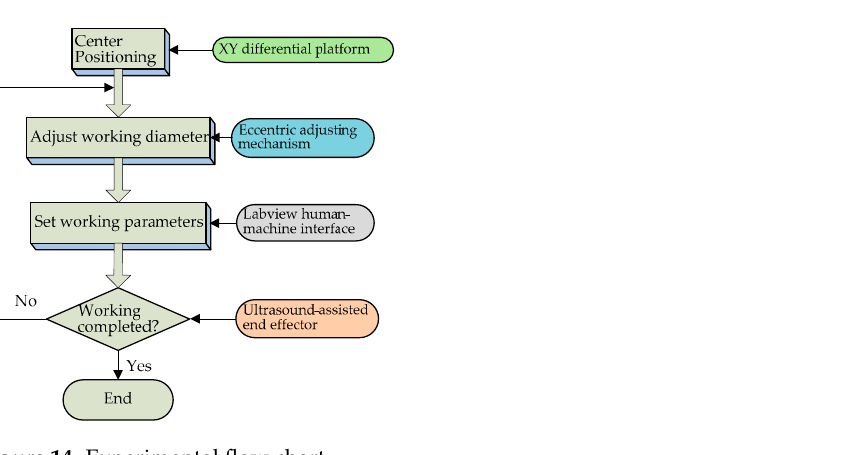
Figure 14. Experimental flow chart.